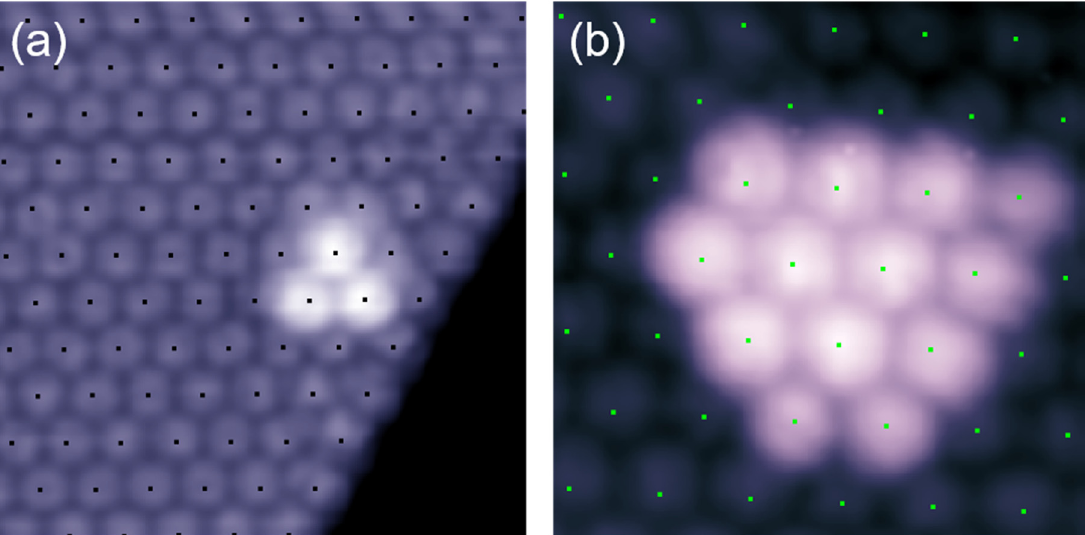
Figure 6. C 60 clusters on top of the first layer. ( a ) A C 60 trimer appeared in the second layer with each molecule located at the atop site, 2.6 V, 10 nm × 10 nm, 25 pA. ( b ) A large cluster with thirteen molecules in the second layer, 2.0 V, 6 nm × 6 nm, 30 pA. The individual molecules within clusters are essentially located at the atop position of the first